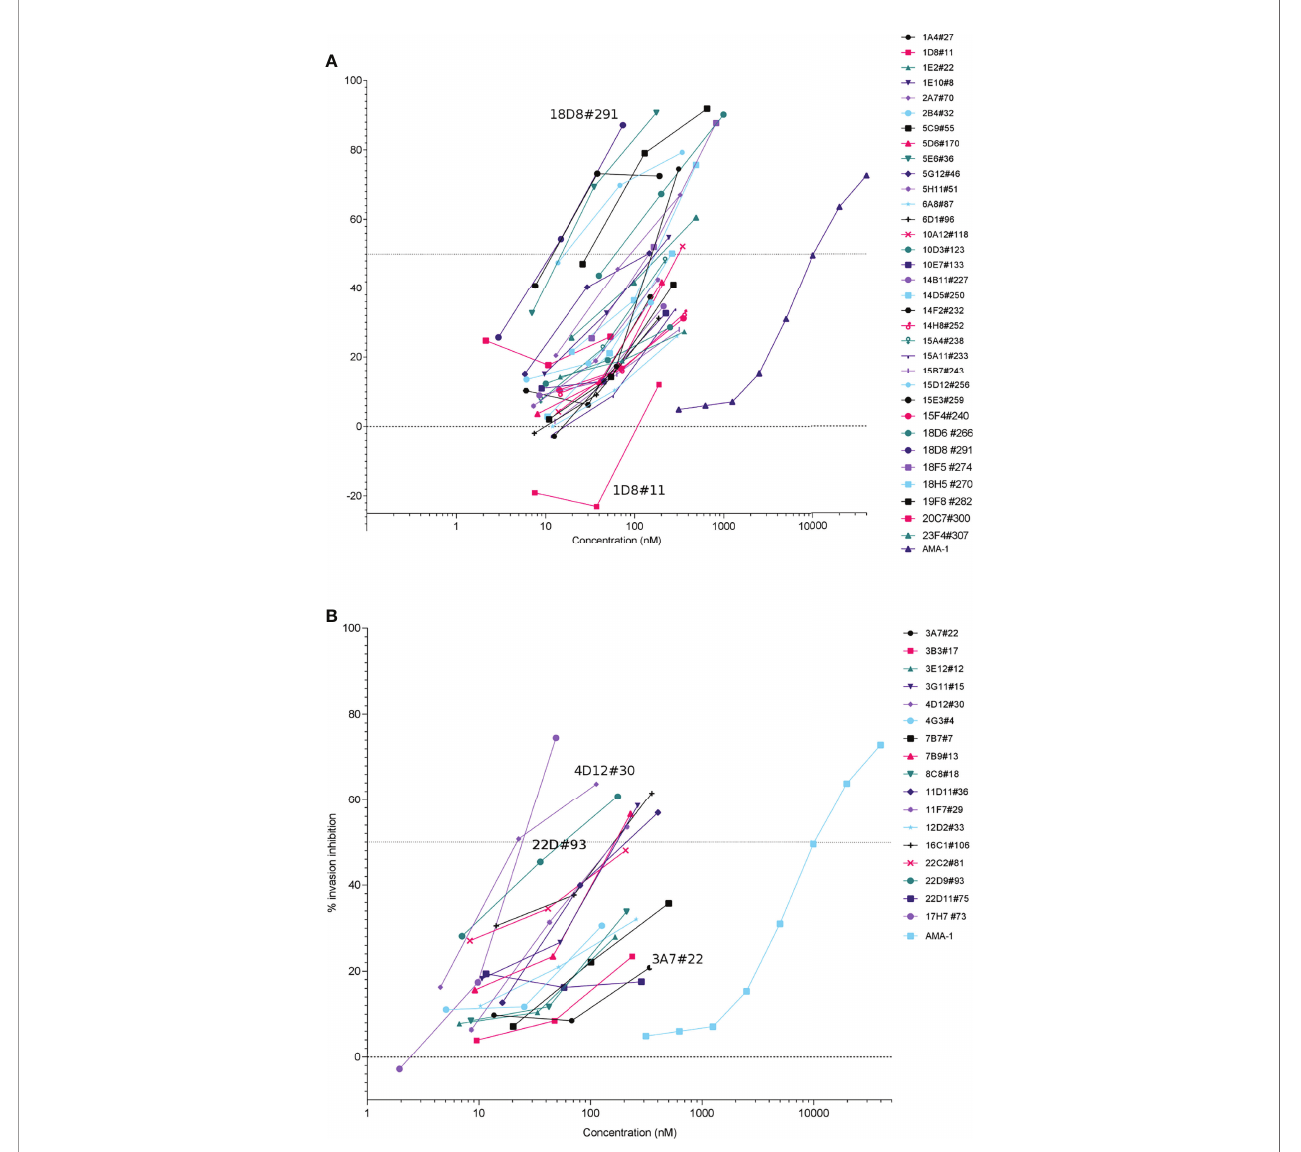
FIGURE 2 | Initial screen of crude cell culture supernatant of expressed anti- Pf RH5 (A) and anti- Pf CyRPA (B) antibodies. Antibodies were tested on P. falciparum FCR3 during one intra-erythrocytic cycle. Invasion inhibition was determined by measuring parasitaemia by fl ow cytometry, percentage inhibition was calculated relative to the no antibody control wells. Invasion of parasite by AMA-1 polyclonal antibodies (BG98 standard) is shown for comparison. Many monoclonal antibodies show high potency at low nanomolar (nM) concentrations as compared to polyclonal anti-AMA-1 where the concentration of total IgG is used rather than the antigen-speci fi c